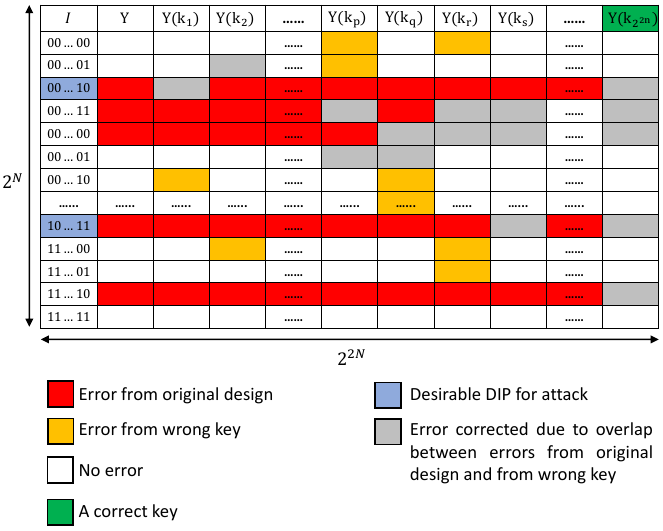
Figure 14: Truth table example for effect of M-CAS